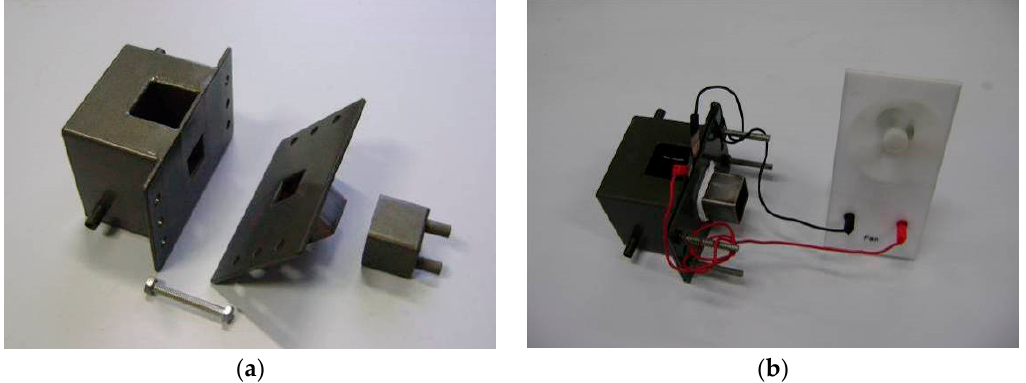
Figure 3. Self-made MEA performance evaluation device and test photos. ( a ) Self-made MEA performance evaluation device; ( b ) photo of MEA driven fan.